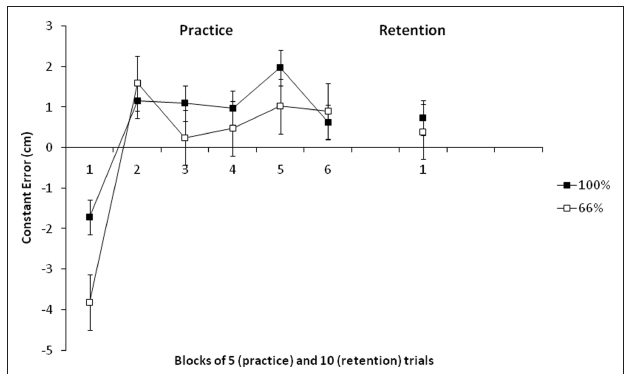
Figure 4 | Variable error scores of the 100 and 66% Kr groups in practice and retention. (Error bars represent